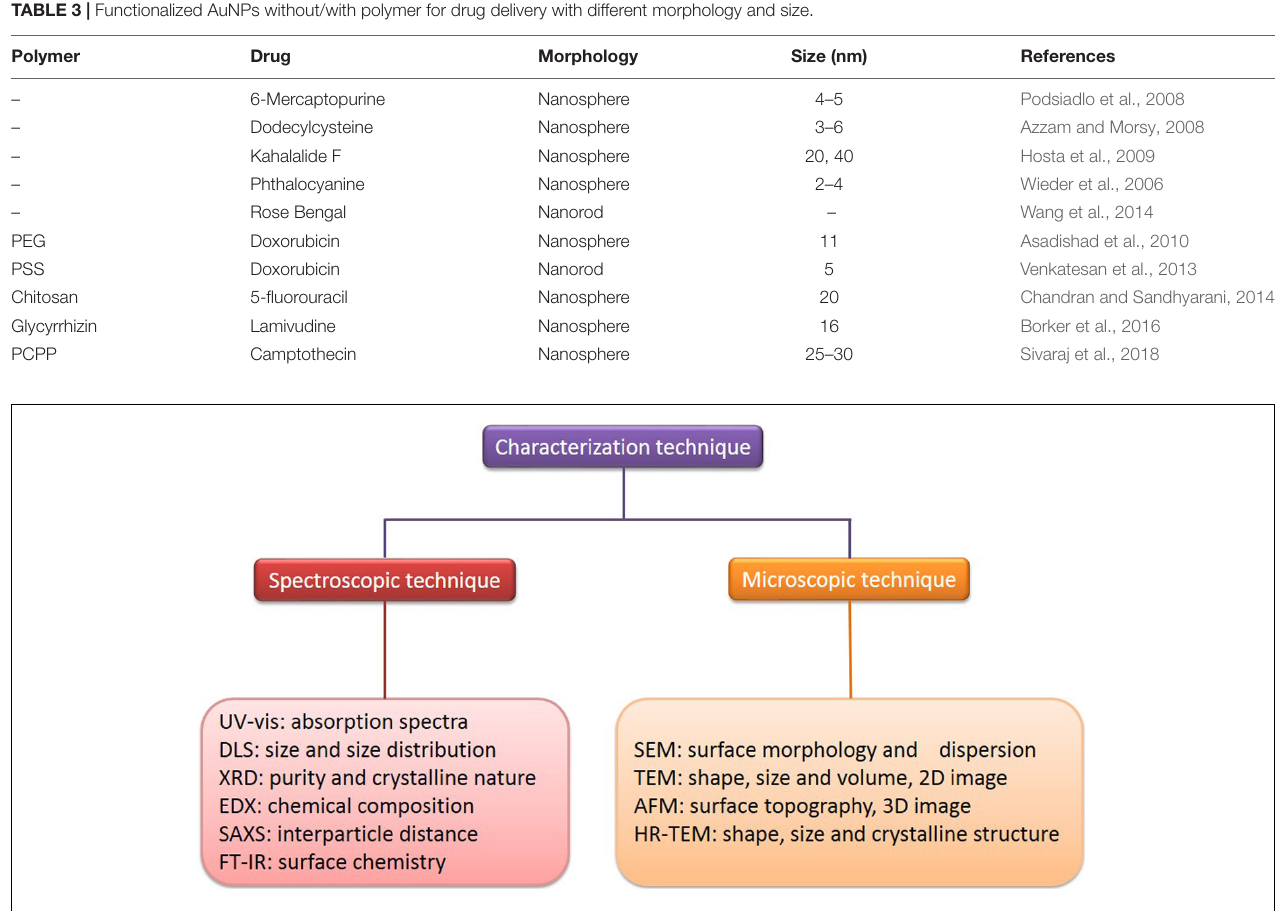
FIGURE 7 | Characterization of